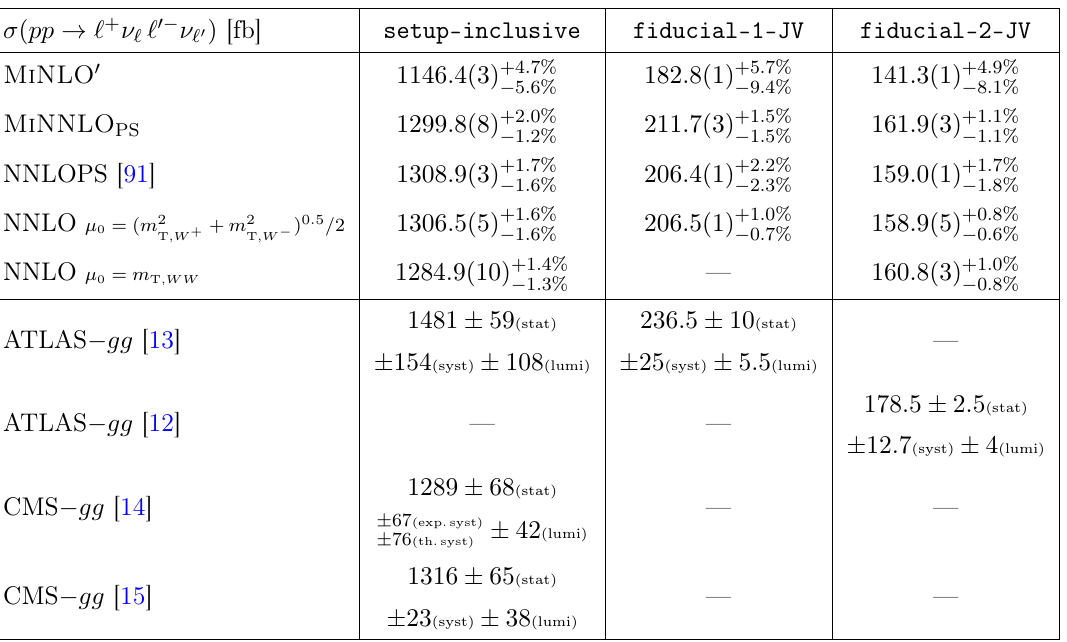
Table 2. W + W (cid:0) cross sections in the fully inclusive phase space and in the fiducial phase spaces defined in table 1. We compare our MiNLO 0 and MiNNLO PS predictions to the NNLOPS results of ref. [91] and to the NNLO cross section obtained with different settings of (cid:22) All NNLO corrections to q (cid:22) q -induced W + W (cid:0) production are taken into account, while the loop- induced gg contribution is excluded. In the last rows, the comparison to CMS and ATLAS data is shown. For the measured inclusive cross sections we have assumed a branching fraction of BR ( W (cid:6) ! ‘ (cid:6) (cid:23) ‘ ) = 0 : 108987 , consistently evaluated with our inputs, and applied one factor for each of the two W bosons. The measured fiducial cross sections have been divided by a factor